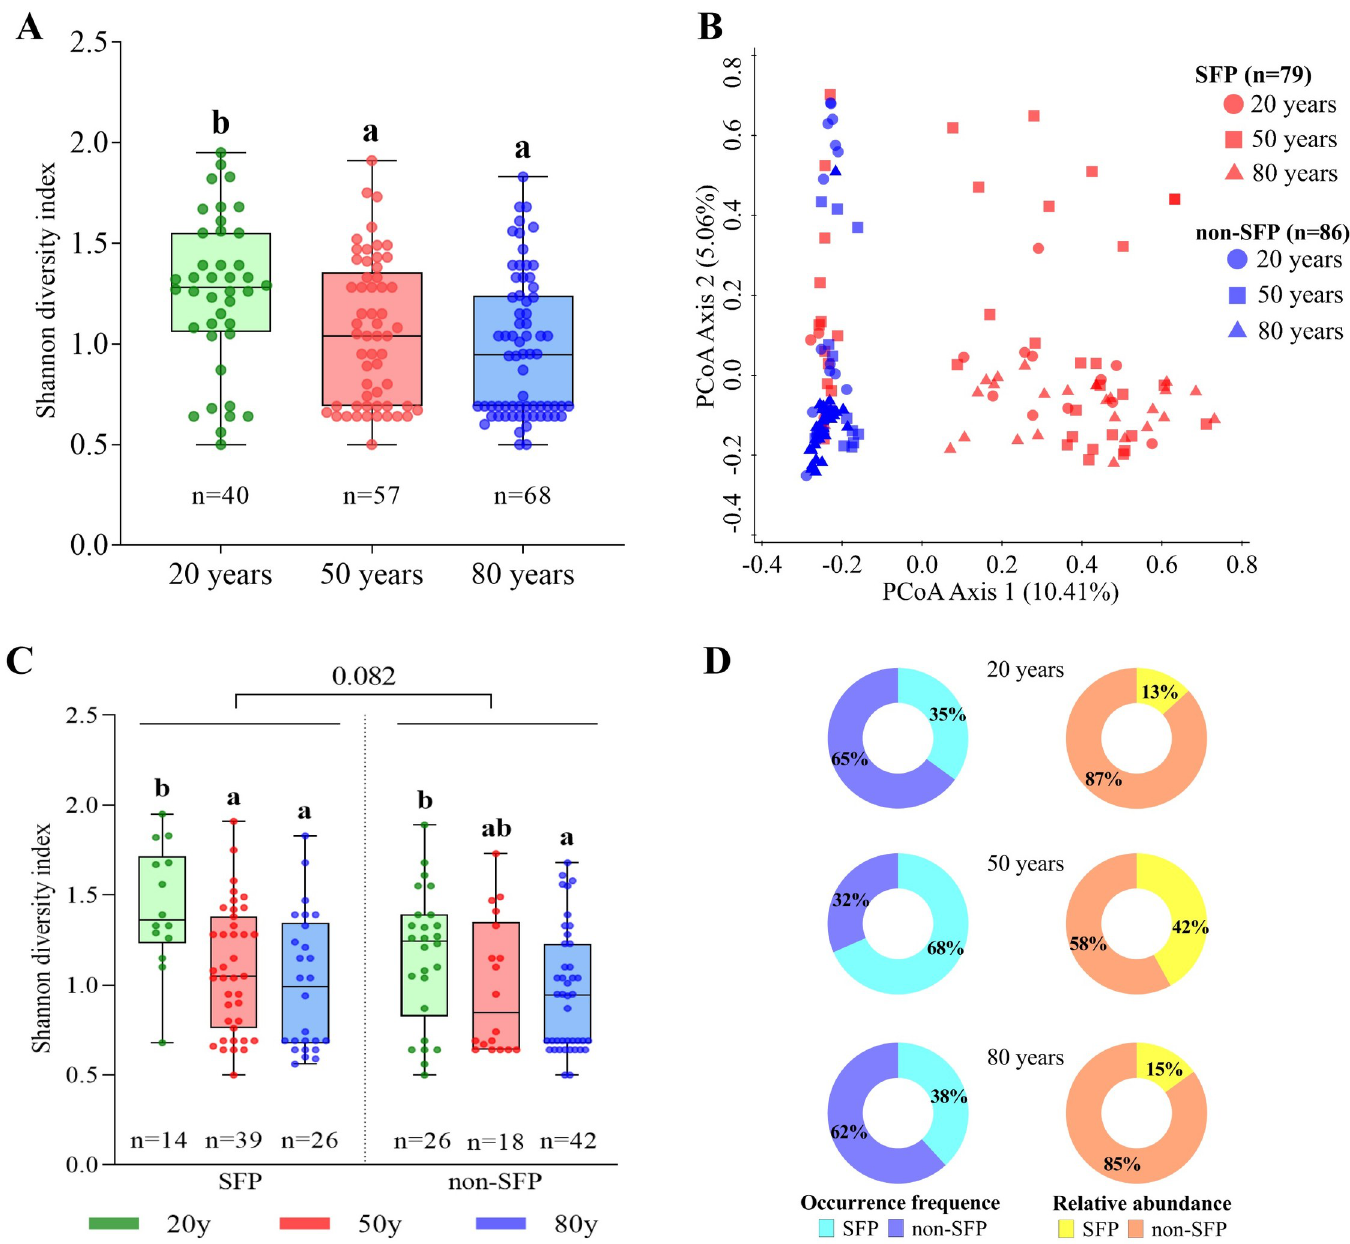
Fig 3. Diversity and structure of the fungal pathogens within leaf spots with multiple infections over the hosts’ invasion history. Shannon diversity (A) and community structure (B) of fungal pathogens at the leaf spot level at different invasion times. (C) Shannon diversity of seedborne foliar pathogens (SFPs) and nonseedborne pathogens (non-SFPs) at the leaf spot level at different invasion times. Each point represents the pathogen community from one leaf spot with multiple infections. In panels (A) and (C), nonparametric analysis with the Mann-Whitney U test was performed to show that the Shannon diversity index difference was significant among the different invasion times based on the different lowercase letters ( p < 0.05). In panel (B), principal coordinate analysis (PCoA) shows the similarity of pathogenic communities among leaf spots with multiple infections. SFP represents a leaf spot containing SFPs that may also cooccur with non-SFPs; non-SFP represents a leaf spot containing only non-SFPs. Percentages of the total explained variation by the PCoA axes in each plot are given in parentheses. (D) The occurrence frequency and relative abundance in leaf spots of SFPs and non-SFPs at different invasion times.